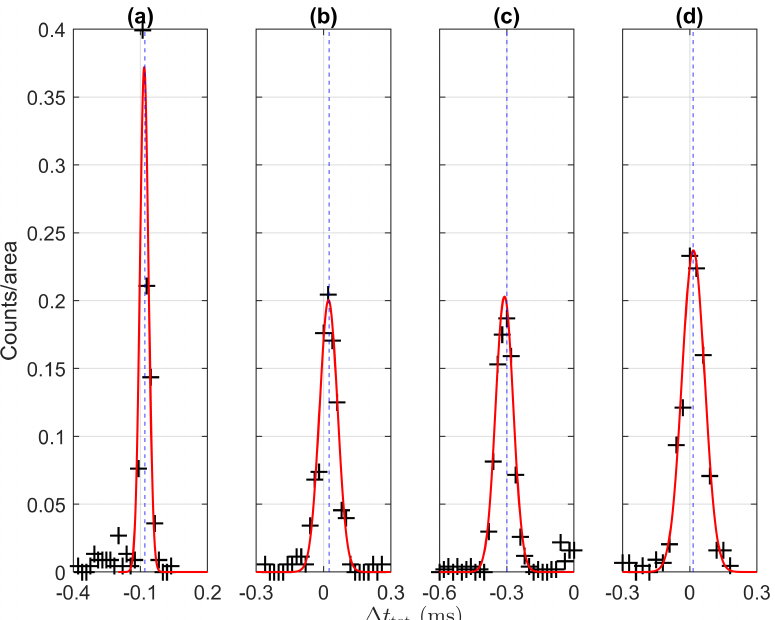
Figure 4. Probability distribution of the all transmitted packets within 1 s with respect to the PPS (crosses) measured according the QTP method for the nominal transmission periods: ( a ) 250, ( b ) 208.3, ( c ) 625, and ( d ) 520.8 µ s. The data are fitted with a Gaussian function (red lines). The dashed blue lines represent ¯ t init . The bin widths are: ( a ) 18, ( b ) 20, ( c ) 20, and ( d ) 30 µ